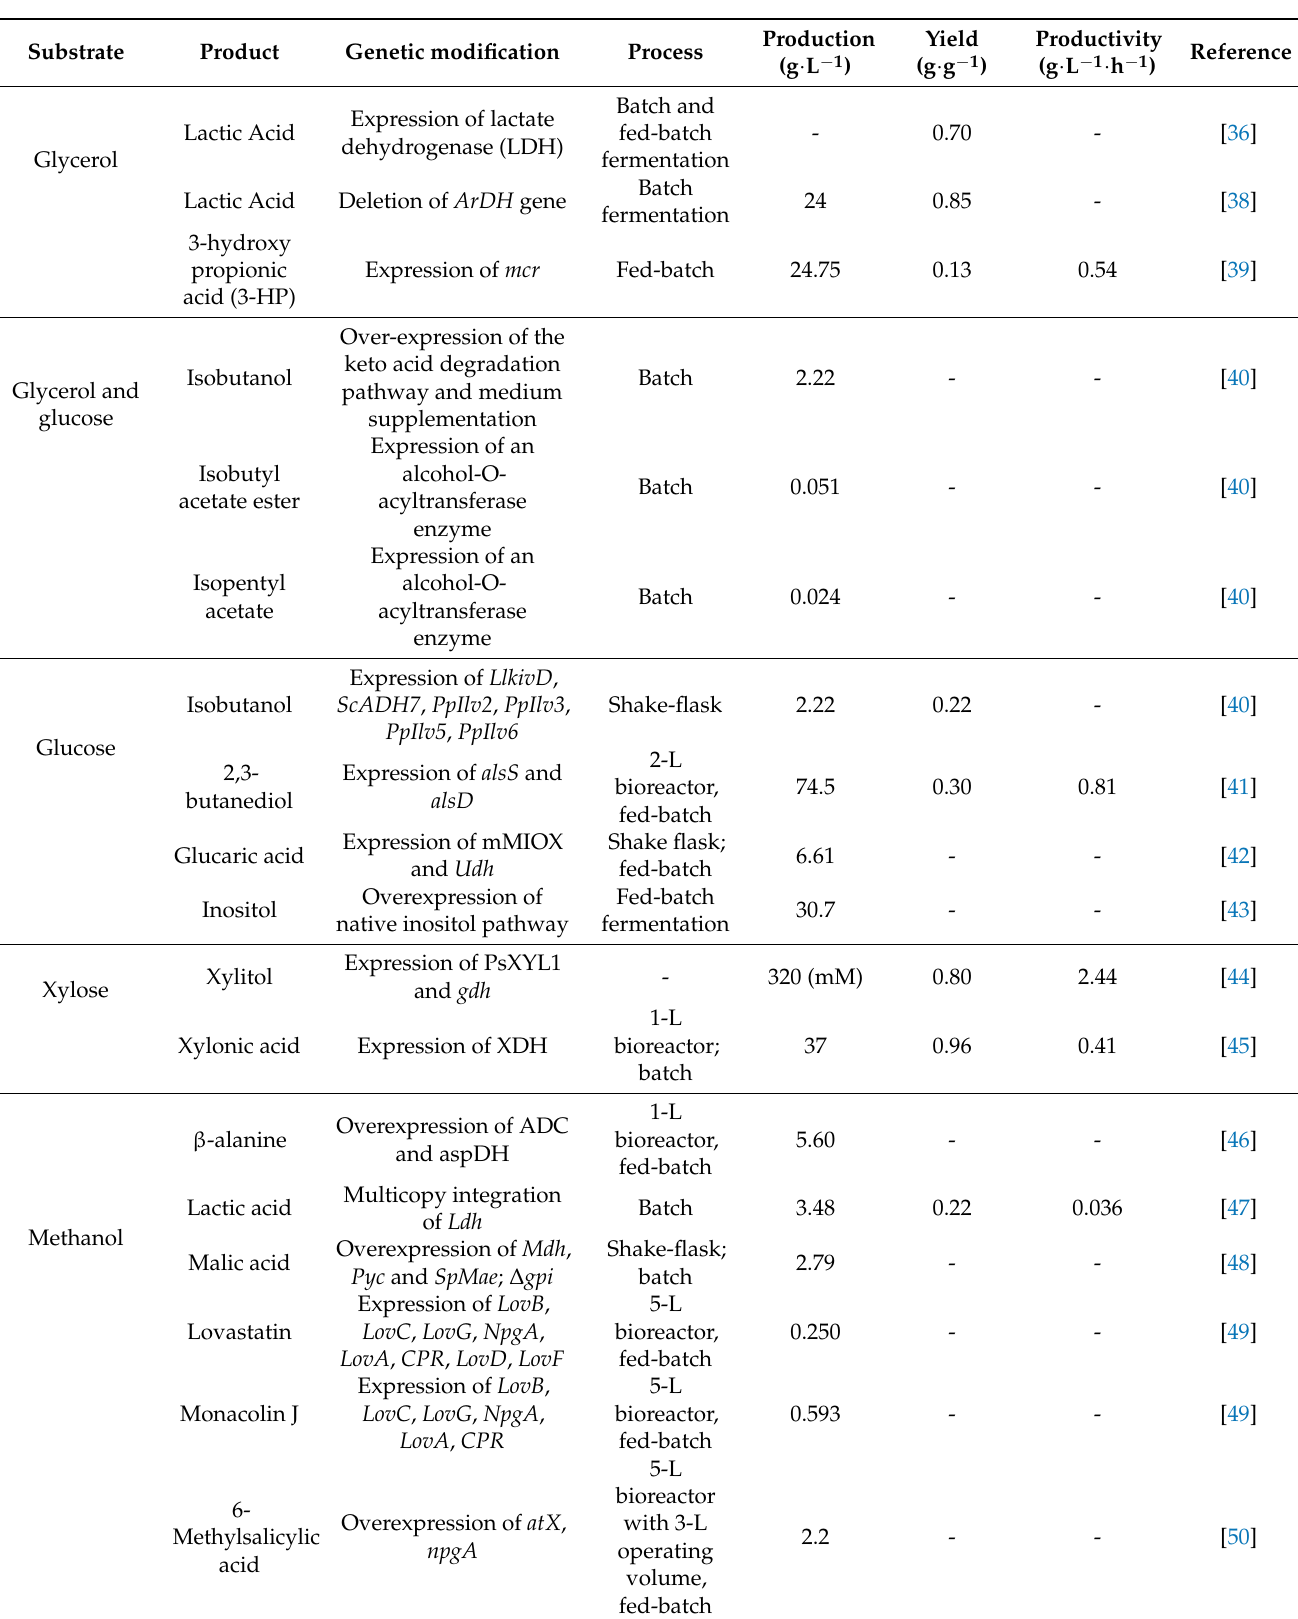
Table 2. Production of chemicals from different carbon sources by engineered K. phaffii